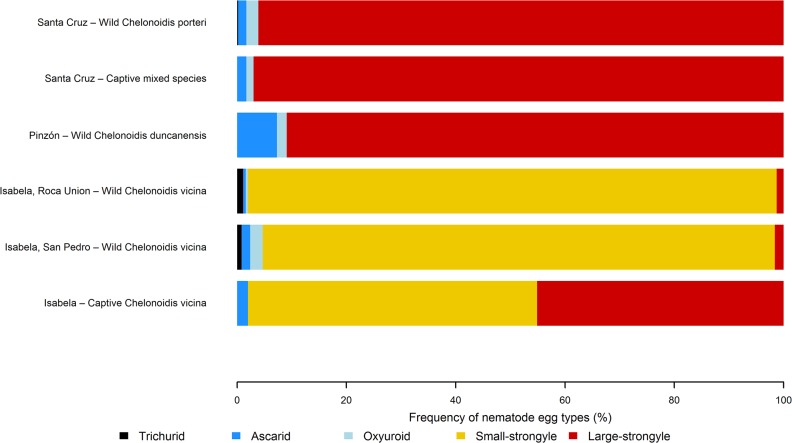
Relative frequency of nematode egg types according to location.Relative frequencies are expressed as a percentage.